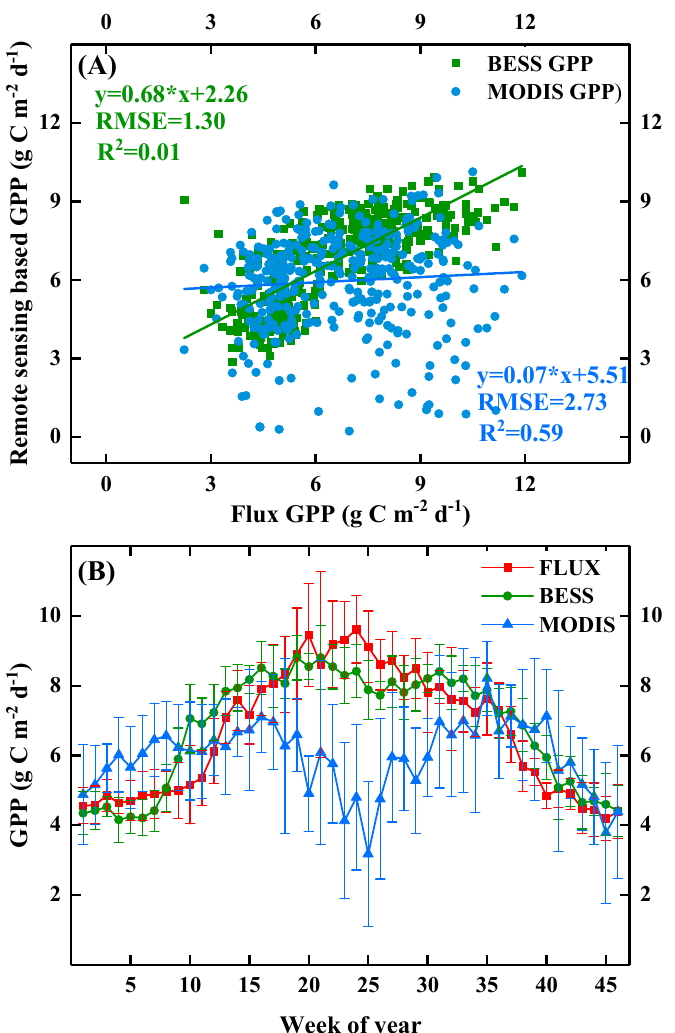
Figure 6. ( A ) Consistency analysis of MODIS GPP, BESS GPP and flux observations from Xishuangbanna and ( B ) comparison of their seasonal trends in 2003–2010.